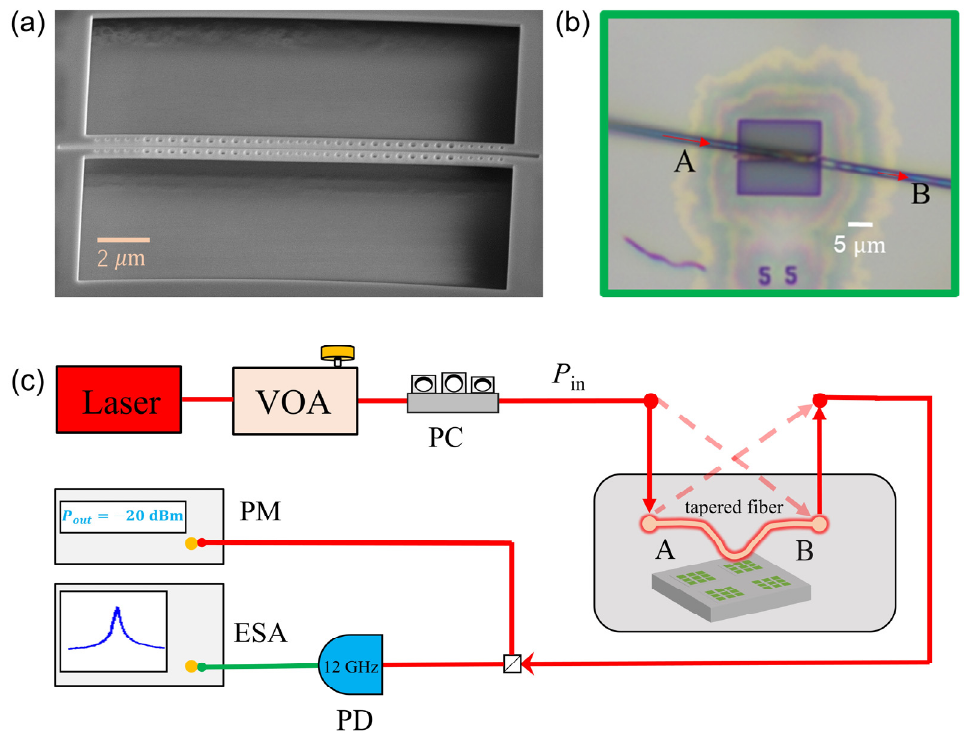
Figure 3. ( a ) Oblique view of scanning electron microscopy (SEM) image of a hetero-OMC zipper cavity. ( b ) Optical microscope image of a zipper cavity with a tapered fiber attached on top. ( c ) Schematic of experimental setup. VOA: variable optical attenuator; PC: polarization controller; PM: power meter; PD: photodetector; ESA: electric spectrum analyzer. Green and red lines represent path of electric signal and light path, respectively.